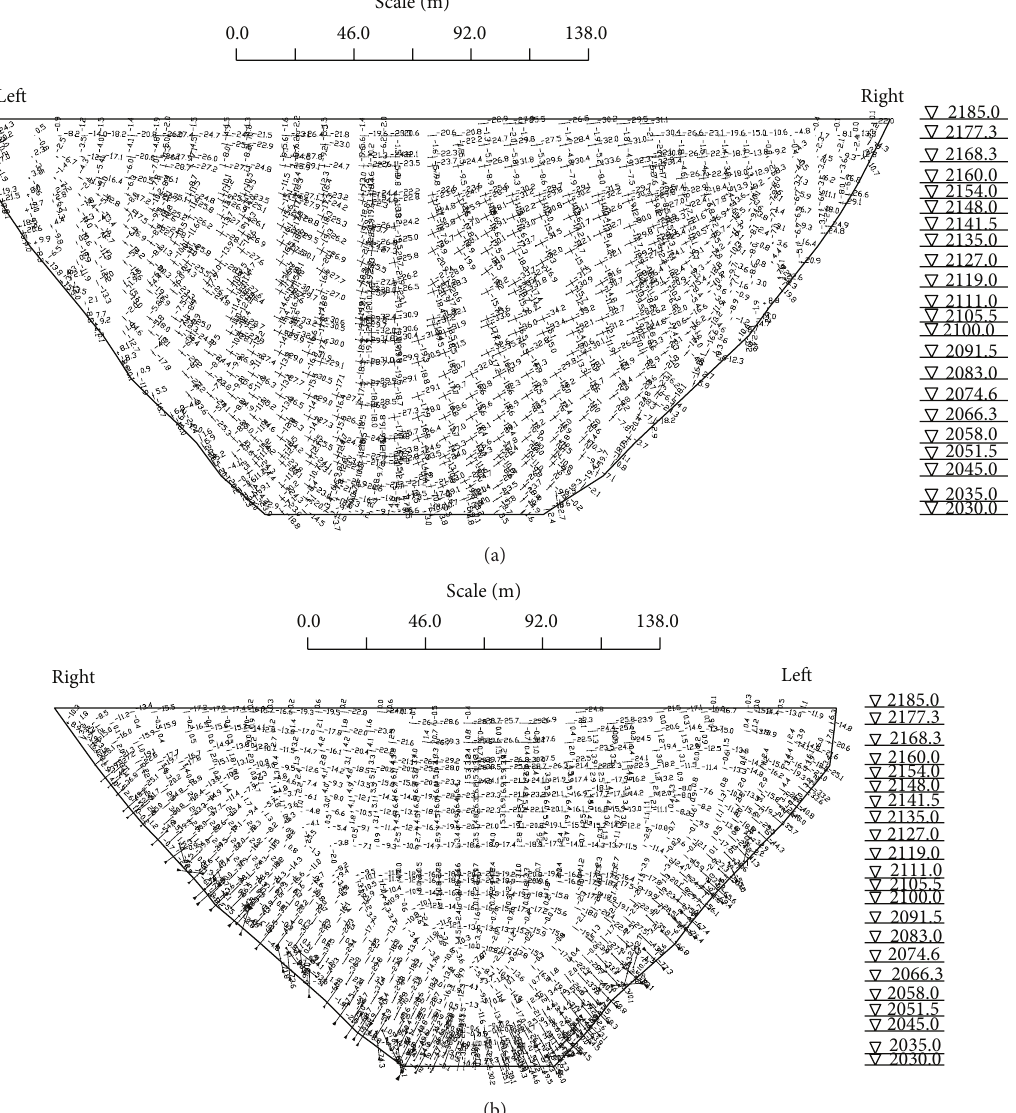
Figure 6: Principal stress vector contour of upstream/downstream surface under analysis case 2: (a) upstream surface; (b) downstream